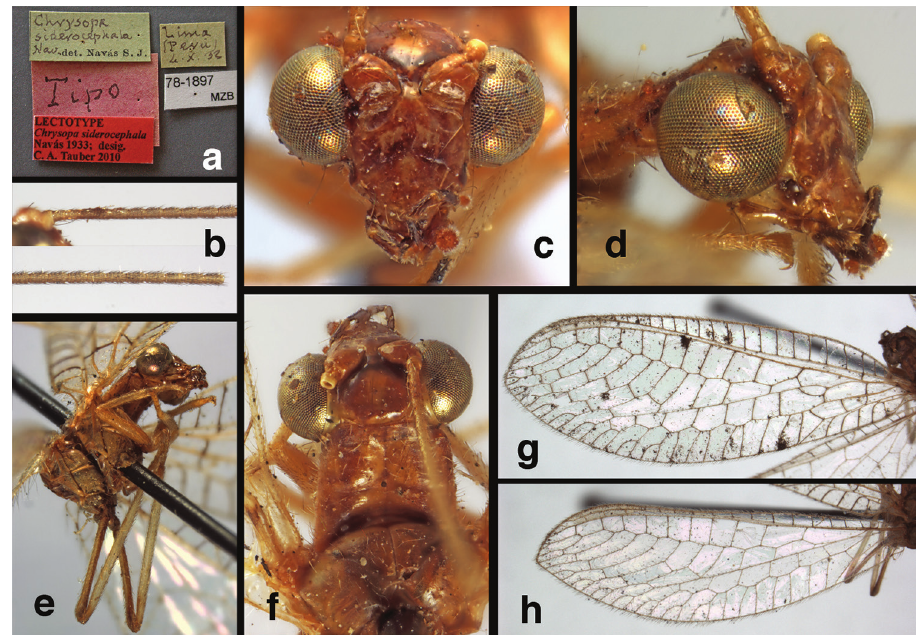
Figure 81. Chrysopa siderocephala Navás: External features, ( a ) labels ( b ) antenna, basal above, distal below ( c ) head, frontal ( d ) head, lateral ( e ) thorax, lateral ( f ) head, prothorax, mesothorax (partial), dorsal ( g ) forewing ( h ) hindwing (Peru, Lima, lectotype, male, MZBS).